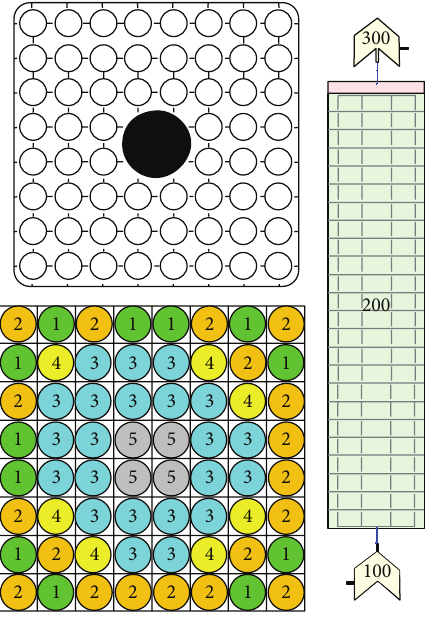
Figure 2: Sketch of assembly type C2A (top left), radial cross section (bottom left), and Axial nodalization (right side) of the TRACE